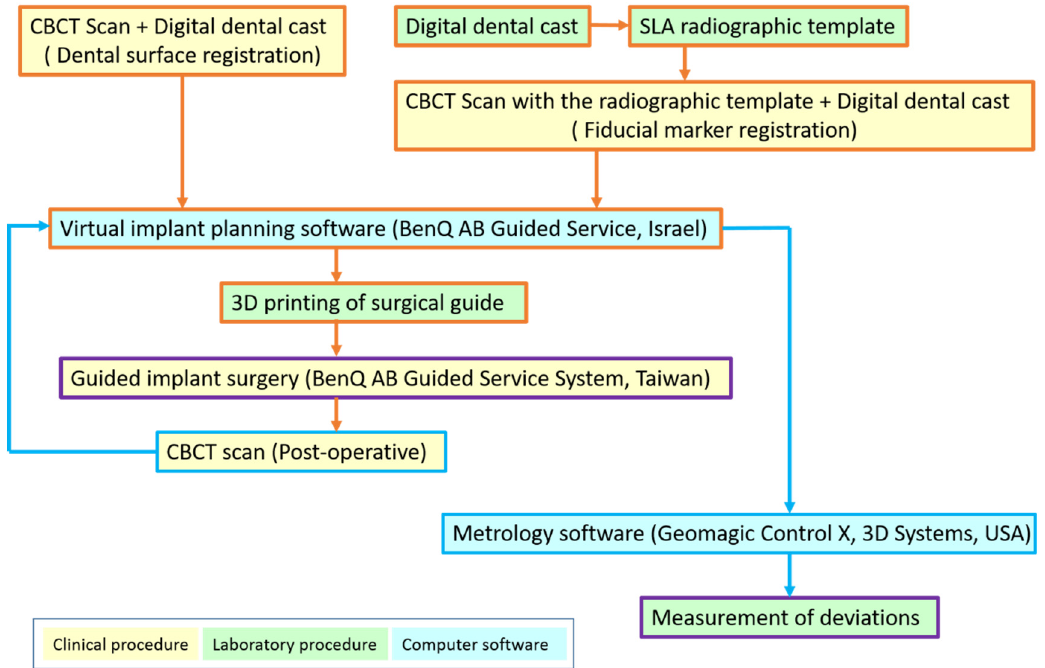
Figure 5. Flowchart summarizing the procedures of this study. Orange arrows indicate the planning and execution of the guided surgery, and blue arrows indicate the deviation measurement.